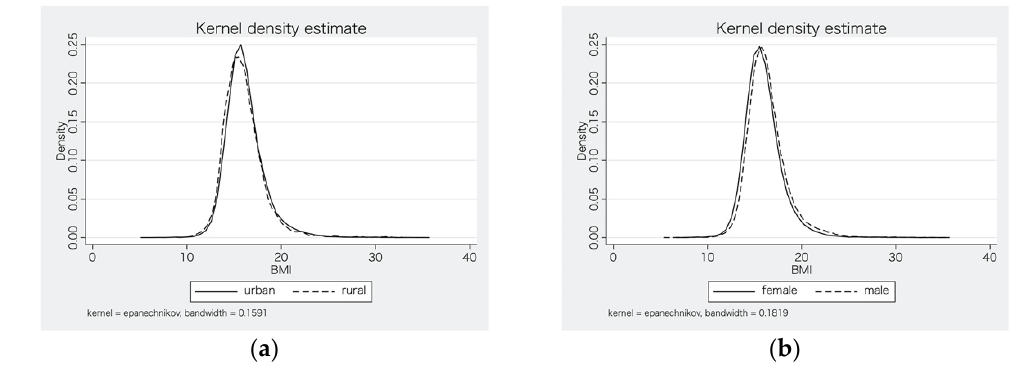
Figure 1. ( a ) Kernel density curves of urban and rural subsamples; ( b ) kernel density curves of female and male subsamples.